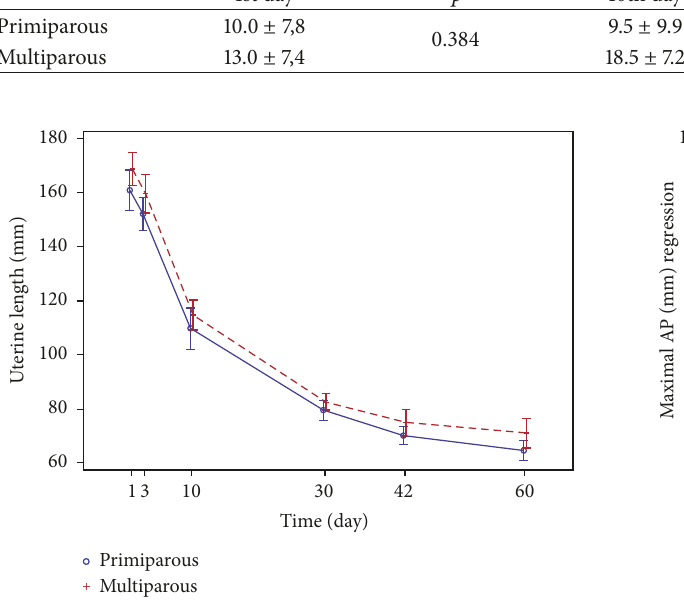
Figure 7: Uterine length (mm) regression.